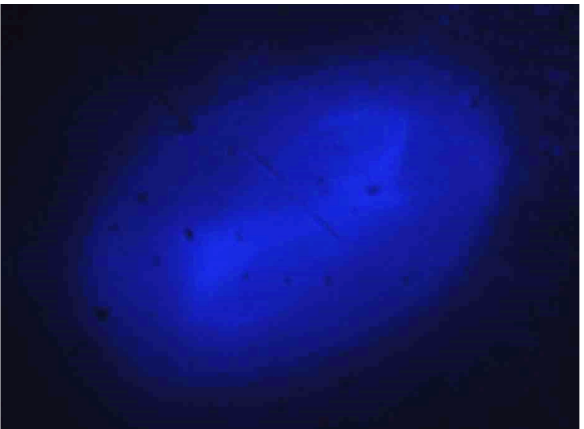
Figure 26. The scanning pattern from the fiber tip under the variable frequency